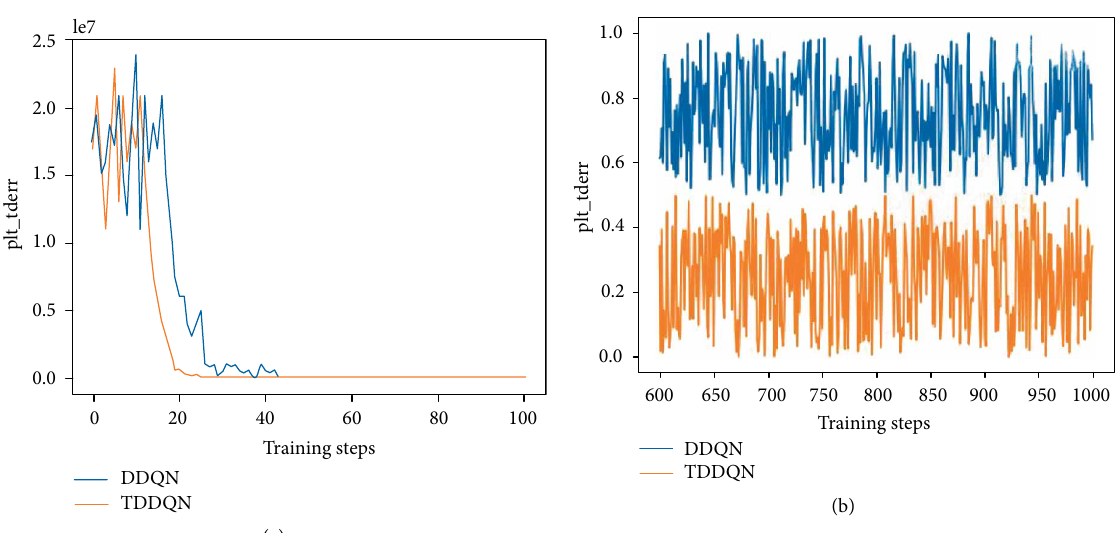
Figure 8: Training curve of 𝑄 target network loss function. Each point is the average loss function value achieved per ten epochs. The y-axis denotes the value of loss function and x-axis denotes iteration epoch. (a) Initial stage of training. (b) Convergence stage of training.